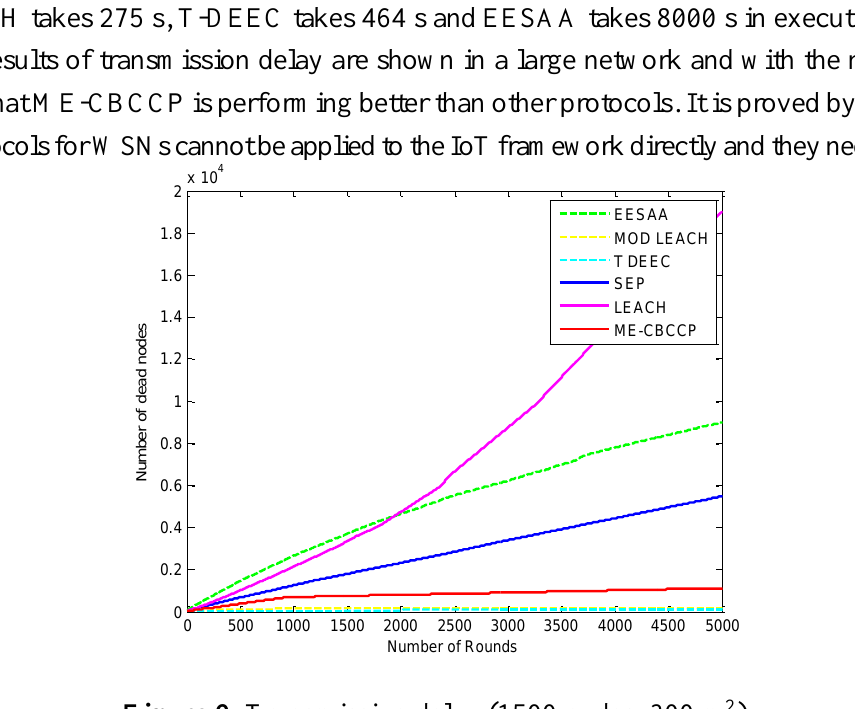
Figure 9. Transmission delay (1500 nodes, 300 m 2